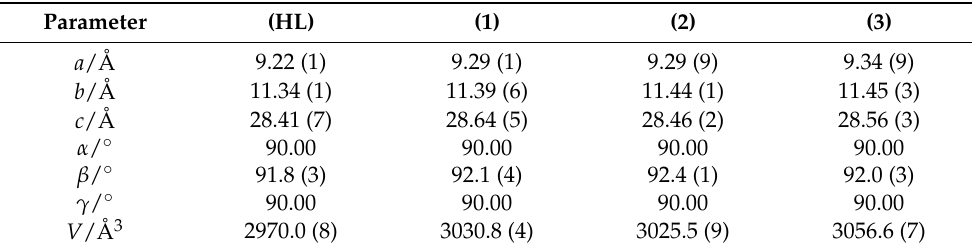
Table 3. Structural parameters of the Schiff base (HL) and metal complexes ( 1 – 3 ).